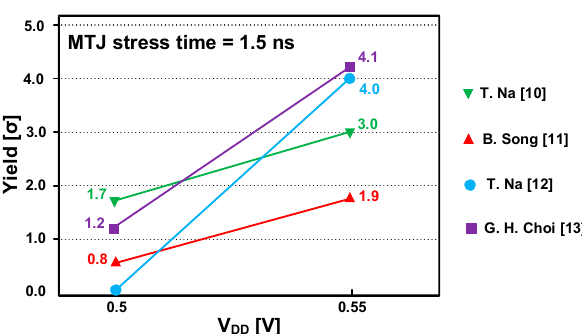
Figure 8. Restore yield of state-of-the-art NVFFs relative to the V DD when the MTJ stress time is increased from 0.9 ns (Figure 7) to 1.5 ns.